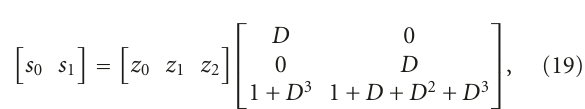
Figure 9: Bit error rate performance of the TS system with n s = 2, 3 and di ff erent bit